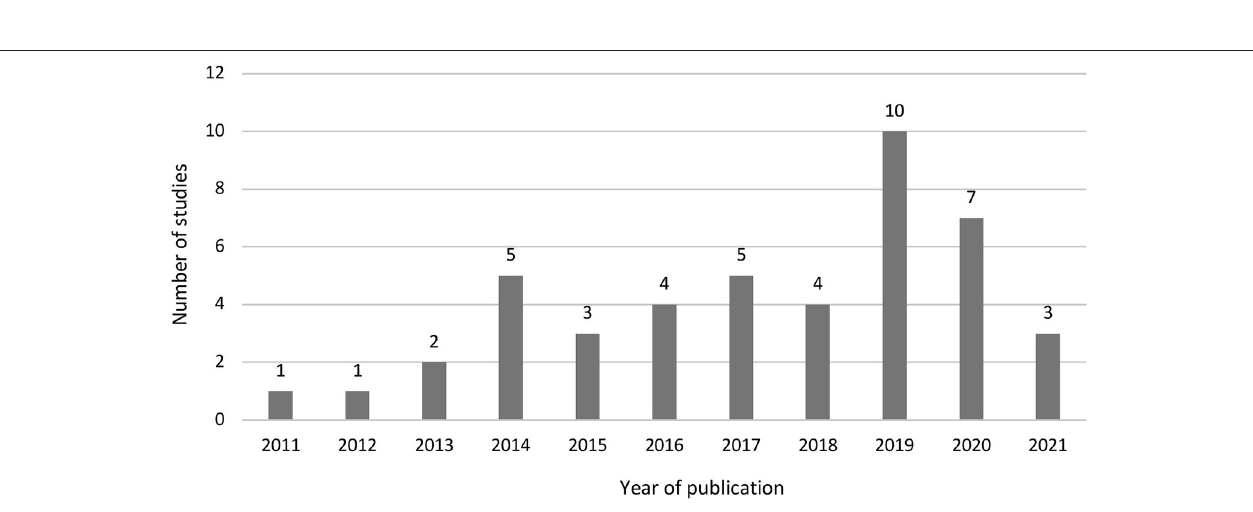
FIGURE 2 | Flow diagram of systematic literature search on empirical applications of CM to assess sensitive/transgressive behavior.